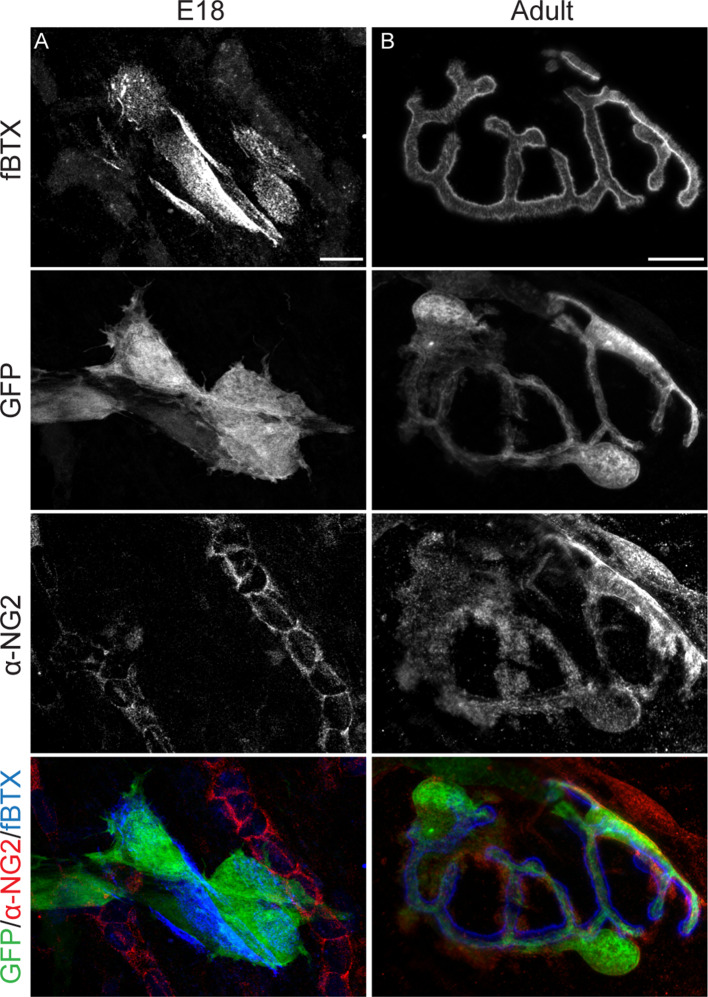
Cells at NMJs express NG2 in adults but not at embryonic timepoints.(A) Immunohistochemical labeling of NG2 revealed that S100β-GFP+ cells at NMJs do not express NG2 in E18 S100β-GFP EDL muscle. (B) In the adult S100β-GFP EDL muscle, however, NG2 is detected in S100β-GFP+ cells at NMJs. Scale bar = 10 μm.